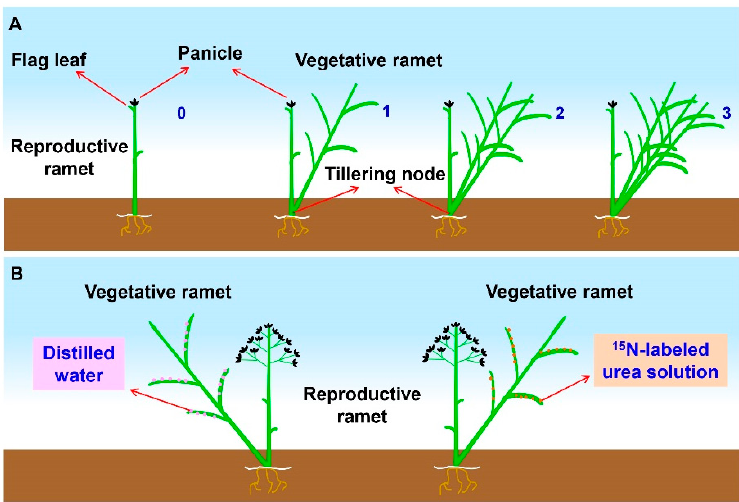
Figure 5. Schematic of the experiment design. ( A ) Schematic representation of the tagging manipulation at the early heading stage of Hierochloe glabra (the Arabic numerals represent the number of vegetative ramets connected to the reproductive ramet by tillering nodes. In each gradient, the panicle top of the reproductive ramet reaches approximately 2 cm over the flag leaf sheath). ( B ) Schematic representation of the stable-isotope ( 15 N) labeling experimental design at the seed-filling stage of Hierochloe glabra . Each ramet pair consists of one reproductive ramet and one vegetative ramet connected by a tillering node.